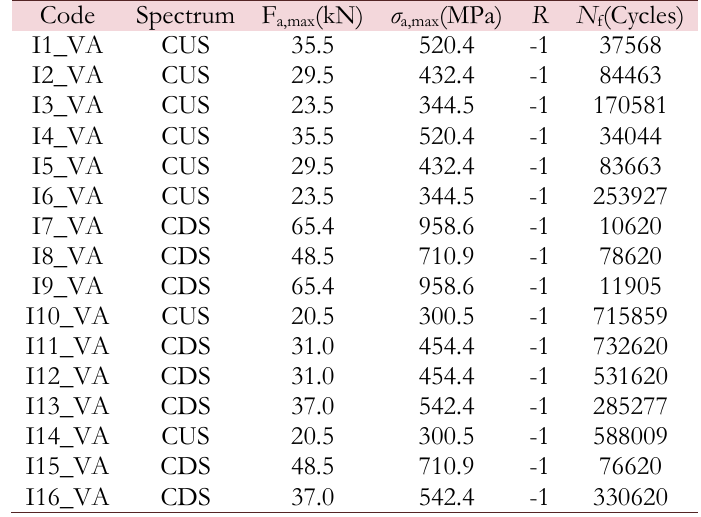
Table 3: Summary of the experimental results generated by testing the notched specimens with root radius equal to 1.2 mm under VA fatigue loading